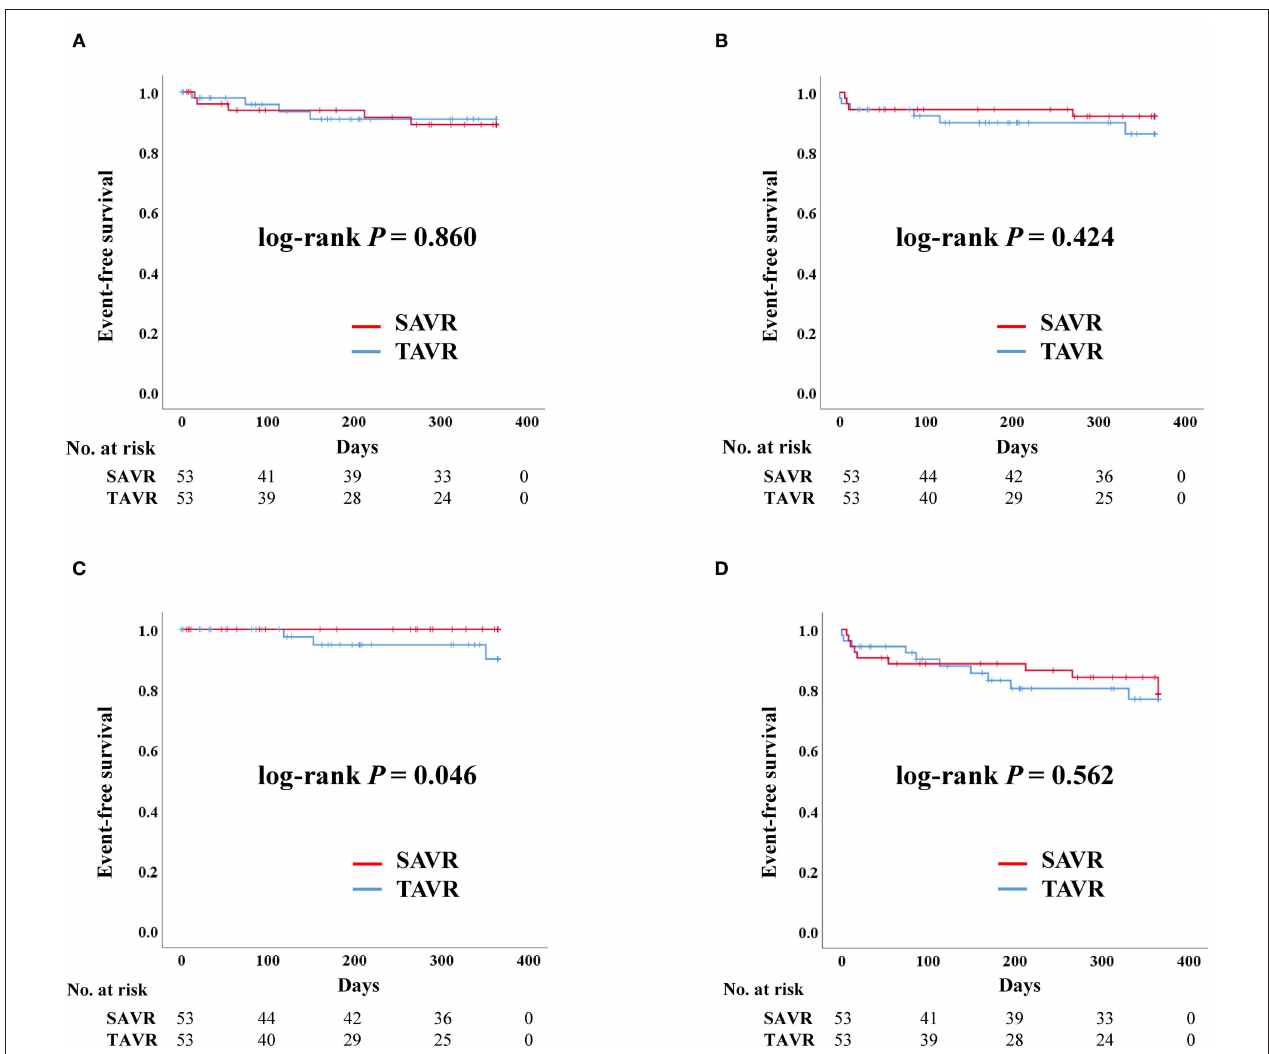
FIGURE 1 | Clinical outcomes of surgical aortic replacement (SAVR) and transcatheter aortic valve replacement (TAVR) after propensity score matching. Composite outcome: composition of admission due to heart failure, stroke, or death. (A) Admission due to heart failure. (B) Death. (C) Stroke. (D) Composite